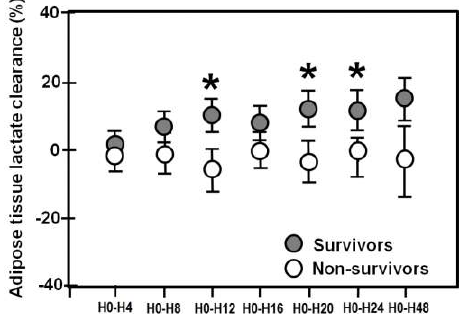
Figure 3. Mean (± SE) adipose tissue lactate clearances in survivors (closed circles) and non-survivors (open circles) over 48 h. Asterisks denote statistically significant differences between the two groups.